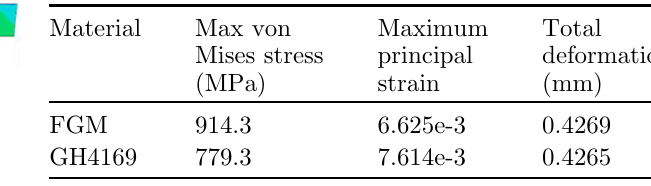
Table 7. Comparison of performance between FGM